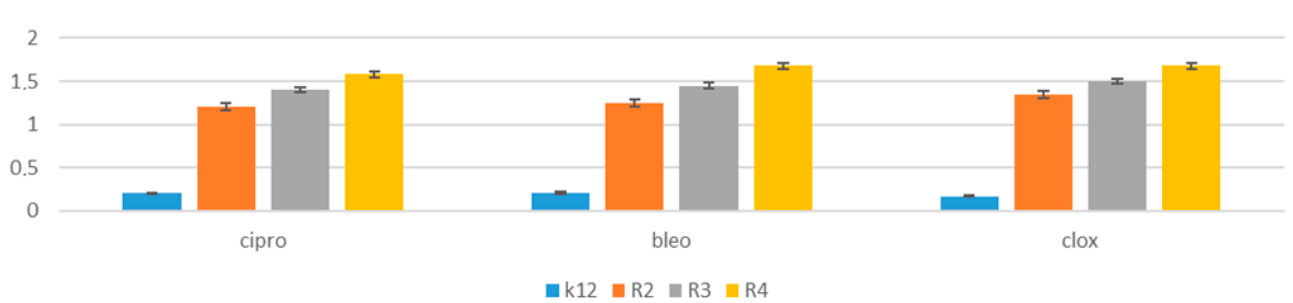
Figure 6. Percentage of plasmid DNA recognized by the Fpg enzymes ( y -axis) with model bacterial, K12, and R2–R4 strains ( x -axis). All analyzed compounds numbered were statistically significant at <0.05 (see Table 2). Figure 7. Examples of MIC with model bacterial strains K12, R2, R3, and R4 for studying the anti- biotics ciprofloxacin (cipro), bleomycin (bleo), and cloxacillin (clox). The x -axis features antibiotics used sequentially. The y -axis features the MIC value in µg/mL − 1 . Figure 8. Percentage of bacterial DNA recognized by the Fpg enzymes in model bacterial strains after ciprofloxacin, bleomycin, and cloxacillin treatment. The compounds were statistically significant at p < 0.05.